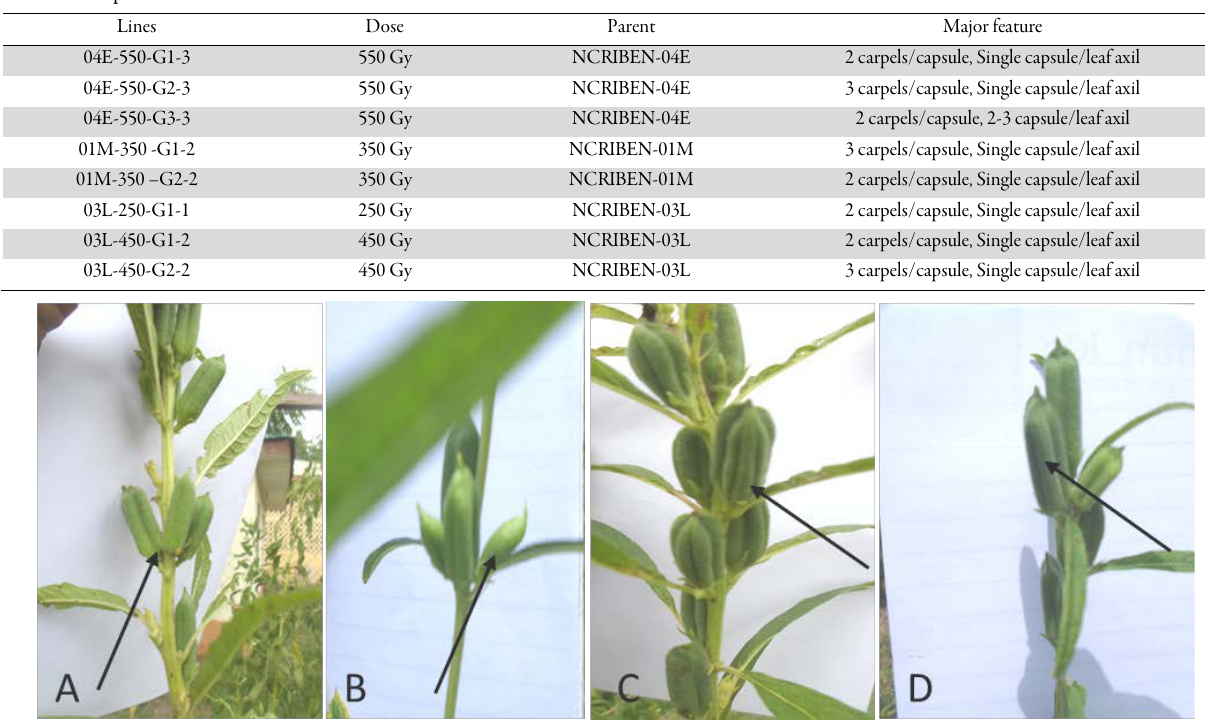
Fig. 1. Mutants from NCRIBEN-04E and control (untreated); A = control with multiple capsule at leaf axil and bicarpellate; B = a mutants with multiple capsules at leaf axil and indehiscent capsule; C = a mutants with tricarpellate capsule; D = a mutant with terminal